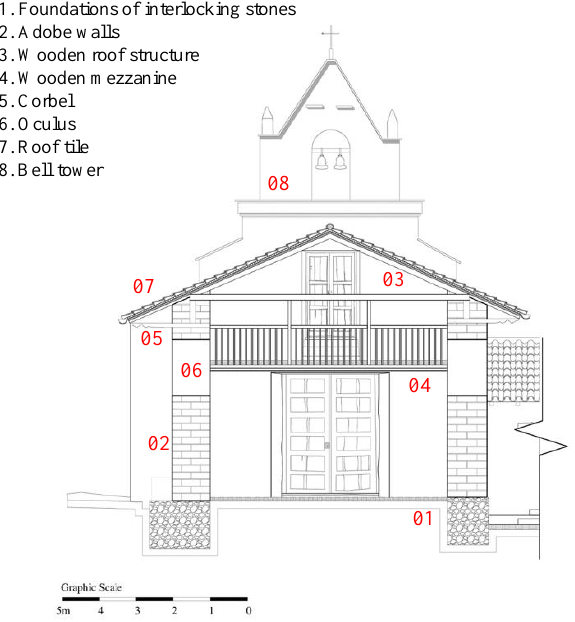
Figure 3. Construction system of the chapel of Susudel, section A-A’. Source: